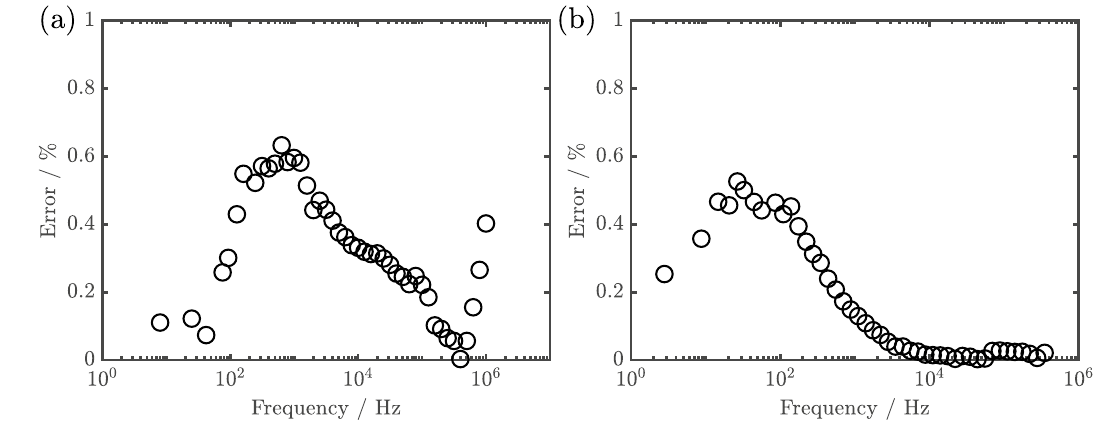
Figure 6. Plot of the estimated error due to the nonlinear component of the fundamental frequencies of dynamic impedance acquired using a multisine intensity of 50 mVpp in ( a ) [ Fe(CN) 6 ] 3 − / 4 − redox couple ( b ) nickel